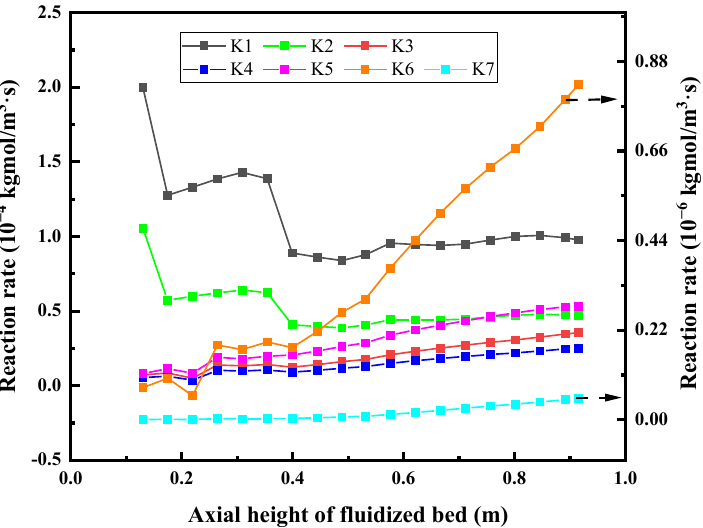
Figure 20. The chemical reaction rate is distributed along the axial direction of the fluidized bed.